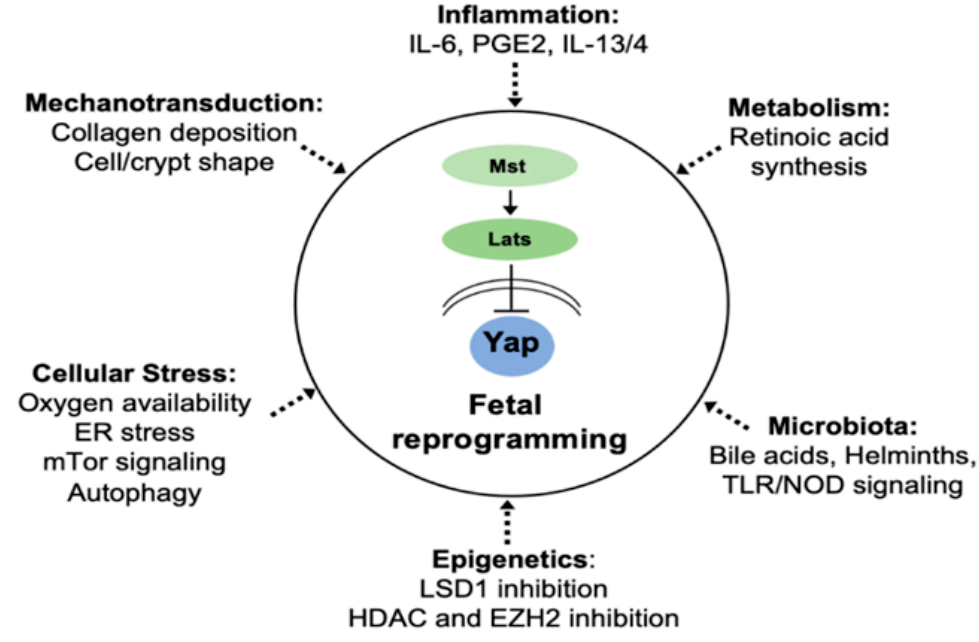
Figure 2. Regulation of fetal reprogramming and dedifferentiation in gastrointestinal tissues. Several processes including collagen deposition, IL-6, prostaglandin E2 (PGE2), retinoic acid synthesis, and bile acid receptor signaling have been reported to directly regulate Hippo/Yap-dependent fetal gene expression. Other processes mentioned and discussed in the text may promote dedifferentiation via alternative mechanisms. However, further investigation into the mechanisms regulating intestinal plasticity is required.